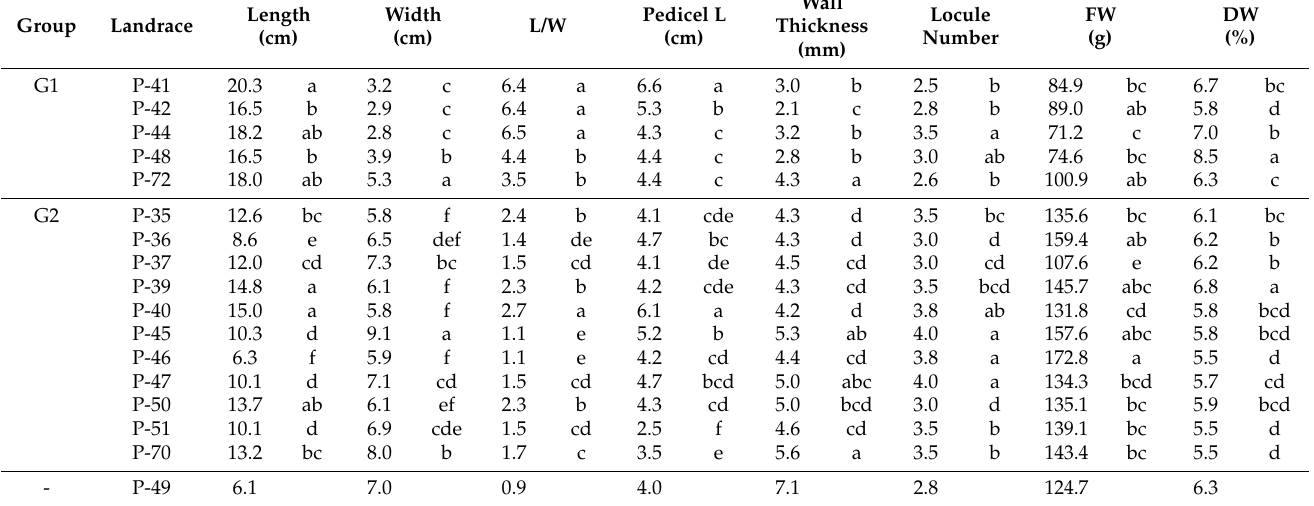
Table 3. Quantitative traits for conventional morphologic descriptors in green fruits of the 17 local pepper landraces cultivated in Spain. Statistics were performed by the formed groups based on fruit shape; G1 = elongated; G2 = triangular, square or blocky. Data belonging to the outlier ungrouped landrace (-, P-49 landrace) are also shown. For each landrace, values represent the mean for the stud- ied conventional morphological descriptors ( n = 10). Different letters in a group indicate significant differences at p ≤ 0.05 (LSD test). L: length; W: width; FW: fresh weight; DW: dry